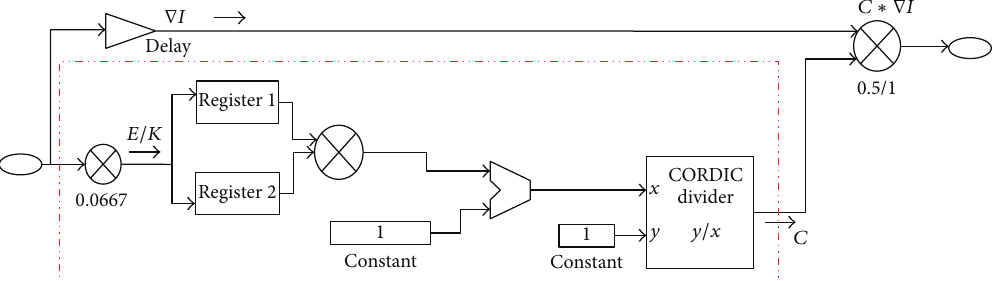
Figure 11: Hardware design for (5) generated for controlling the blurring intensity, that is, diffusion coefficient ( 𝐶 𝑛 ).